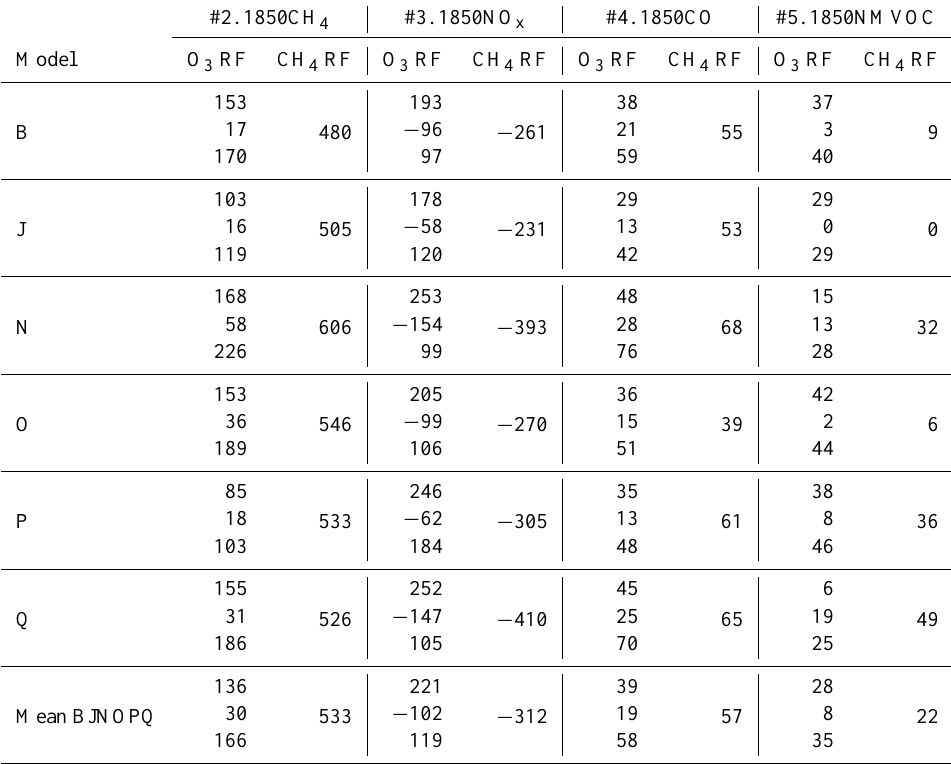
Table 8. Tropospheric ozone and methane radiative forcings (mW m − 2 ) for each model and attribution experiments #2–5 relative to ex- periment #1 (year 2000s). For methane radiative forcings in experiments #2–5, an equilibrium [CH 4 ] is calculated based on the diagnosed perturbation to the methane lifetime (Table 7); the RF is then calculated from the difference between the prescribed and equilibrium methane concentrations. For ozone radiative forcings, three numbers are given: the uppermost is the RF from the calculated ozone field (e.g., Fig. S5); the middle value is the inferred ozone RF associated with the methane adjustment to equilibrium; the lower number is the net ozone RF. #2. 1850CH 4 #3. 1850NO